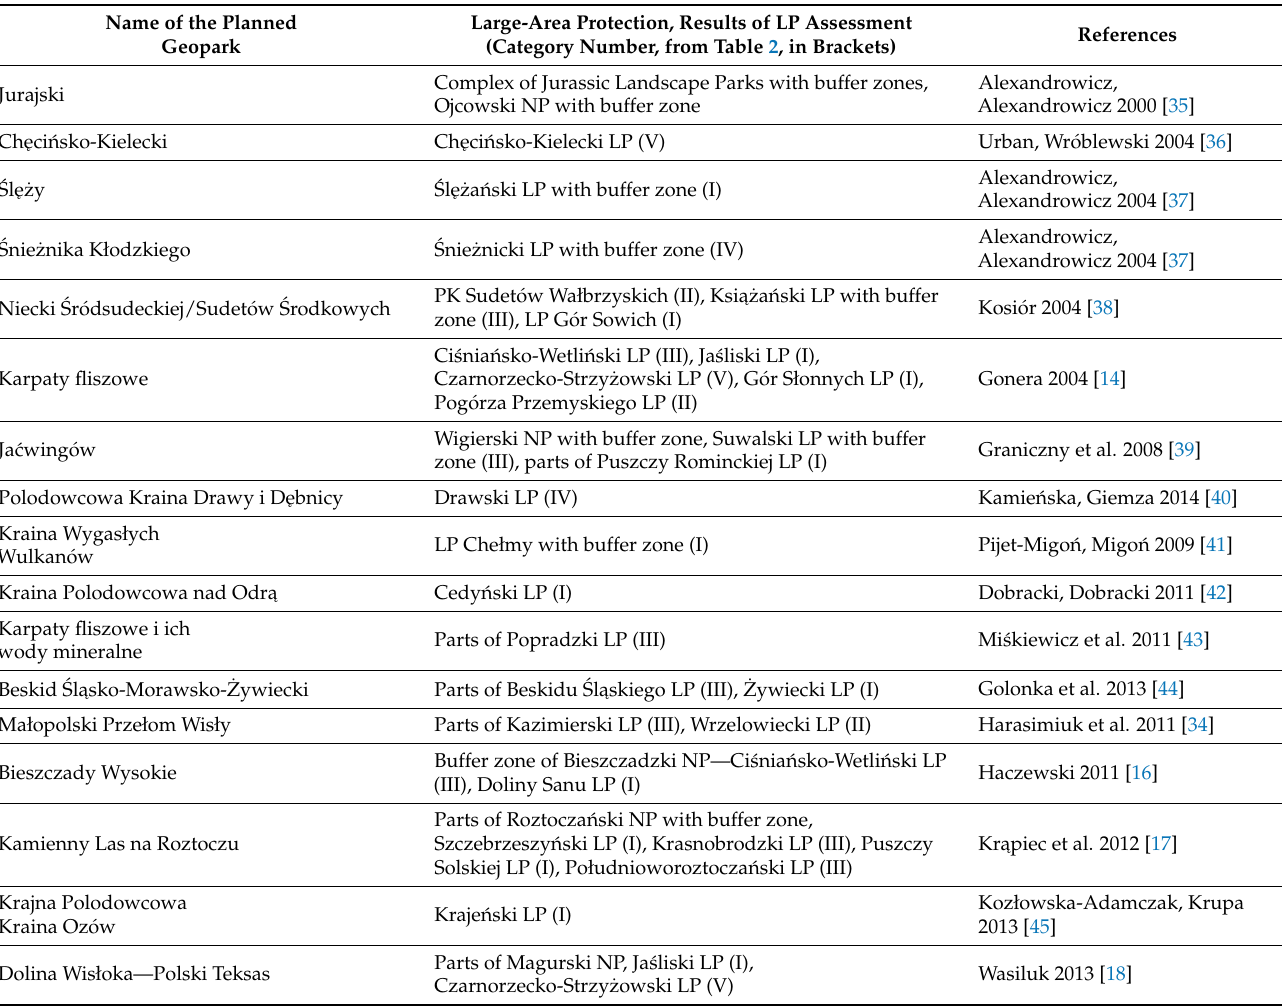
Table 3. Planned geoparks versus landscape parks (based on Alexandrowicz, Mi´skiewicz (2016) [23], modified according to the assessment